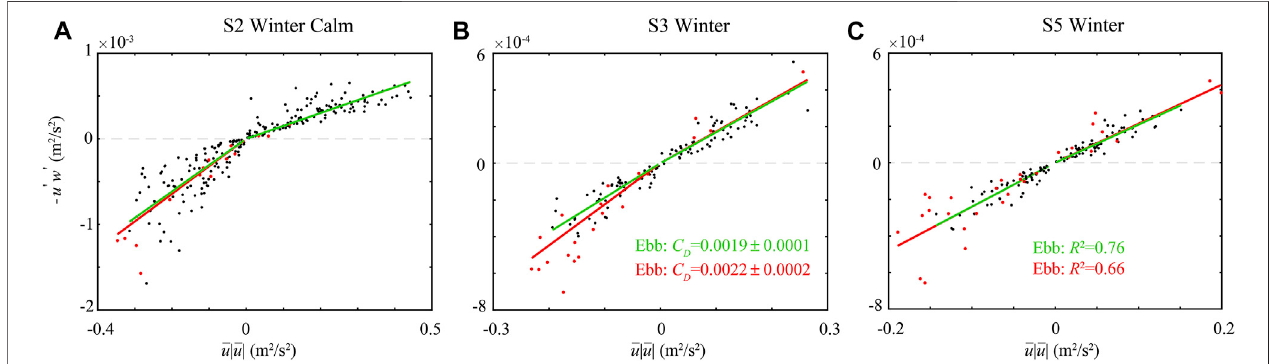
FIGURE12| CorrelationbetweenmeasuredturbulentReynoldsstress, − u ′ w ′ ,andthesign-preservingsquaredADV ’ sburstmeanvelocity, (cid:1) u | (cid:1) u | ,forthe (A) S2calm period, (B) S3,and (C) S5inwinterwithoutthestrongwaveobservations(reddots).Thebest fi tlineswithoutthestrongwaveobservations(reddots)areshowningreen and the best fi t lines of all data are shown in red, with the slopes indicating the drag coef fi cients, C D , for ebb tide (top) and fl ood tide (bottom).